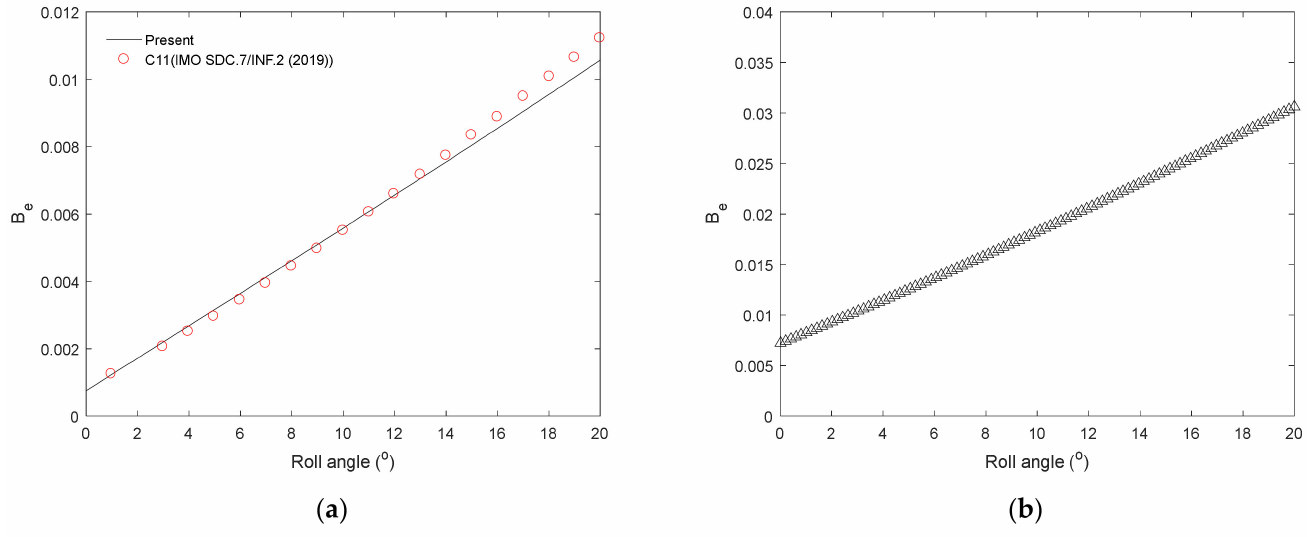
Figure 5. The roll damping coefficients depends on the roll angle estimated by Ikeda’s method (cid:16) (cid:17) (cid:113) B B e = ˆ B 44 = B 44 . ( a ) C11 container ship ( − : Present, 2 g ρ ∇ B 2